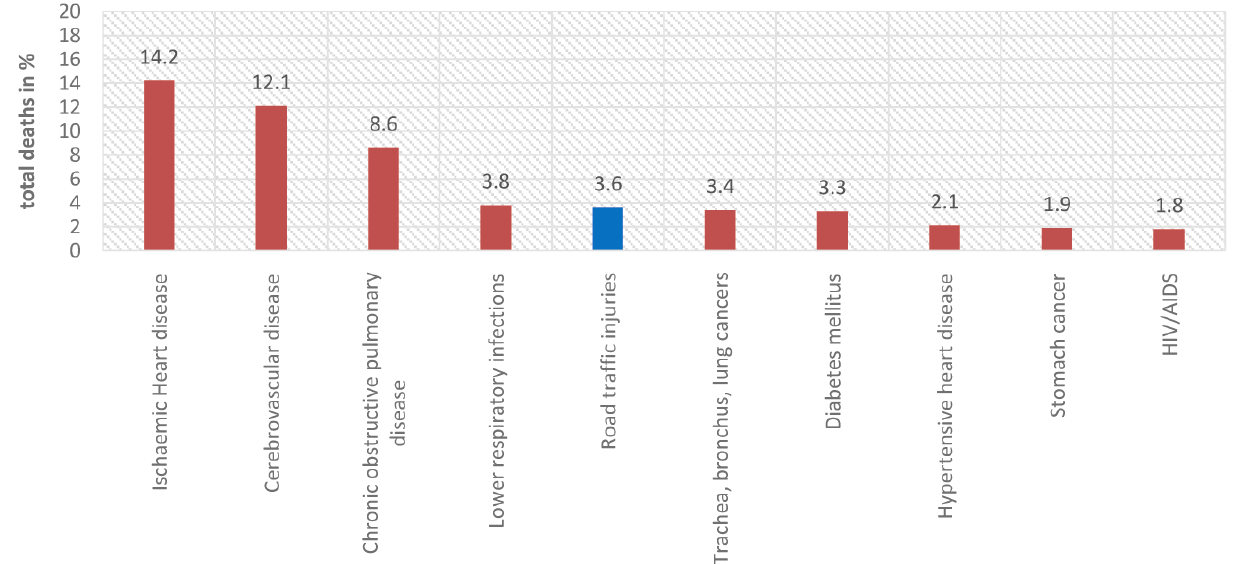
Figure 1. Leading Causes of death in 2030 predicted by WHO 2 . (generated using Microsoft